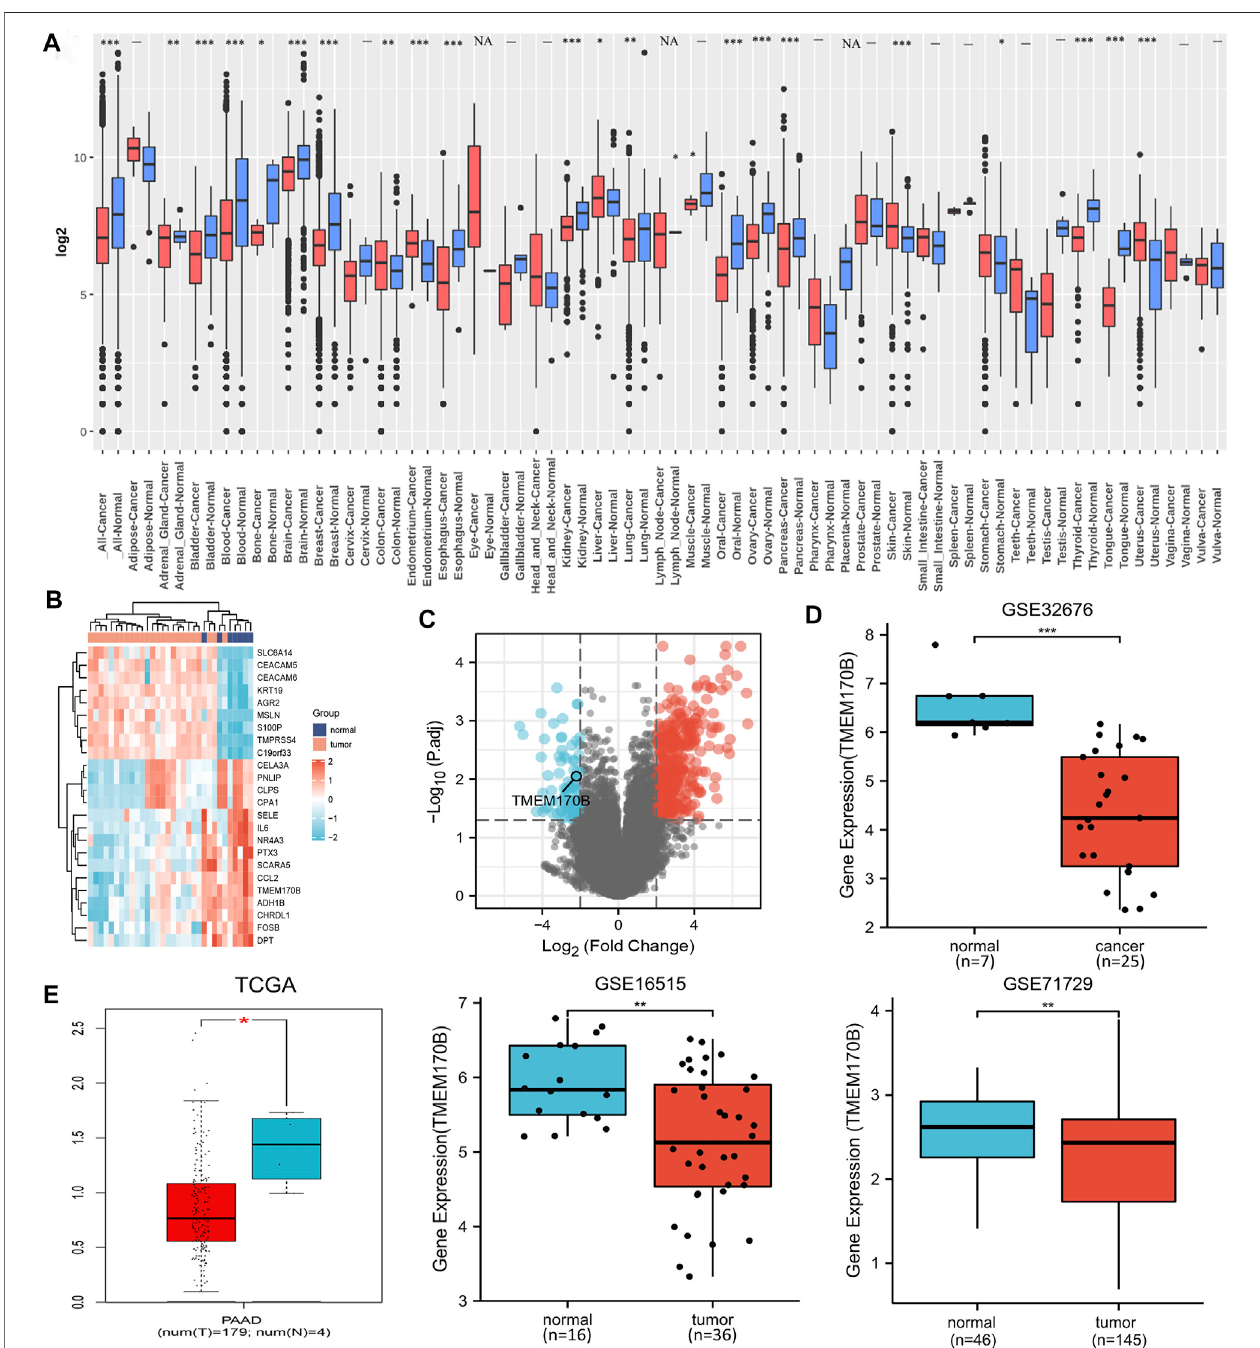
FIGURE 1 | TMEM170B mRNA expression levels in different tumors and corresponding adjacent normal tissues. (A) The pan-cancer TMEM170B expression status was analyzed using GENT2 based on the GEO database. (B) The heat map of the top 24 ranked DEGs. (C) The volcano plot of all DEGs, red represents up- regulated, blue represents down-regulated genes. (D,E) The expressions of TMEM170B in pancreatic adenocarcinoma and the corresponding nontumor tissues were inferred by analyzing the TCGA and GEO databases. ns: not signi fi cant. * p < 0.05; ** p < 0.01; *** p < 0.001.